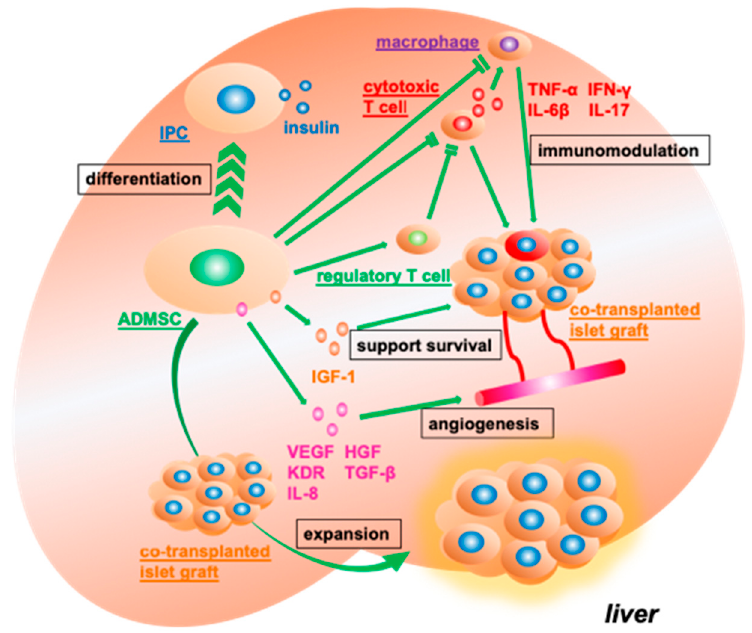
Figure 4. Supporting the function and engraftment of co-transplanted islet grafts. When adipose tissue-derived mesenchymal stromal cells (ADMSCs) are transplanted with islets, the cells can contribute to improving type 1 diabetes mellitus (T1DM) via several mechanisms. ADMSCs release functional molecules, including vascular endothelial growth factor (VEGF), hepatocyte growth factor (HGF), kinase insert domain receptor (KDR), transforming growth factor- β (TGF- β ), interleukin-8 (IL-8), and insulin-like growth factor-1 (IGF-1) to promote angiogenesis and support the survival of co-transplanted islet grafts. ADMSCs upregulate regulatory T cells and downregulate cytotoxic T cells and macrophages. Inflammatory cytokines, including tissue necrosis factor- α (TNF- α ), interferon gamma (IFN- γ ), interleukin-6 β (IL-6 β ), and IL-17, are suppressed in the presence of ADMSCs. In addition, ADMSCs can differentiate into insulin-producing cells (IPCs) and expand co-transplanted islet grafts.